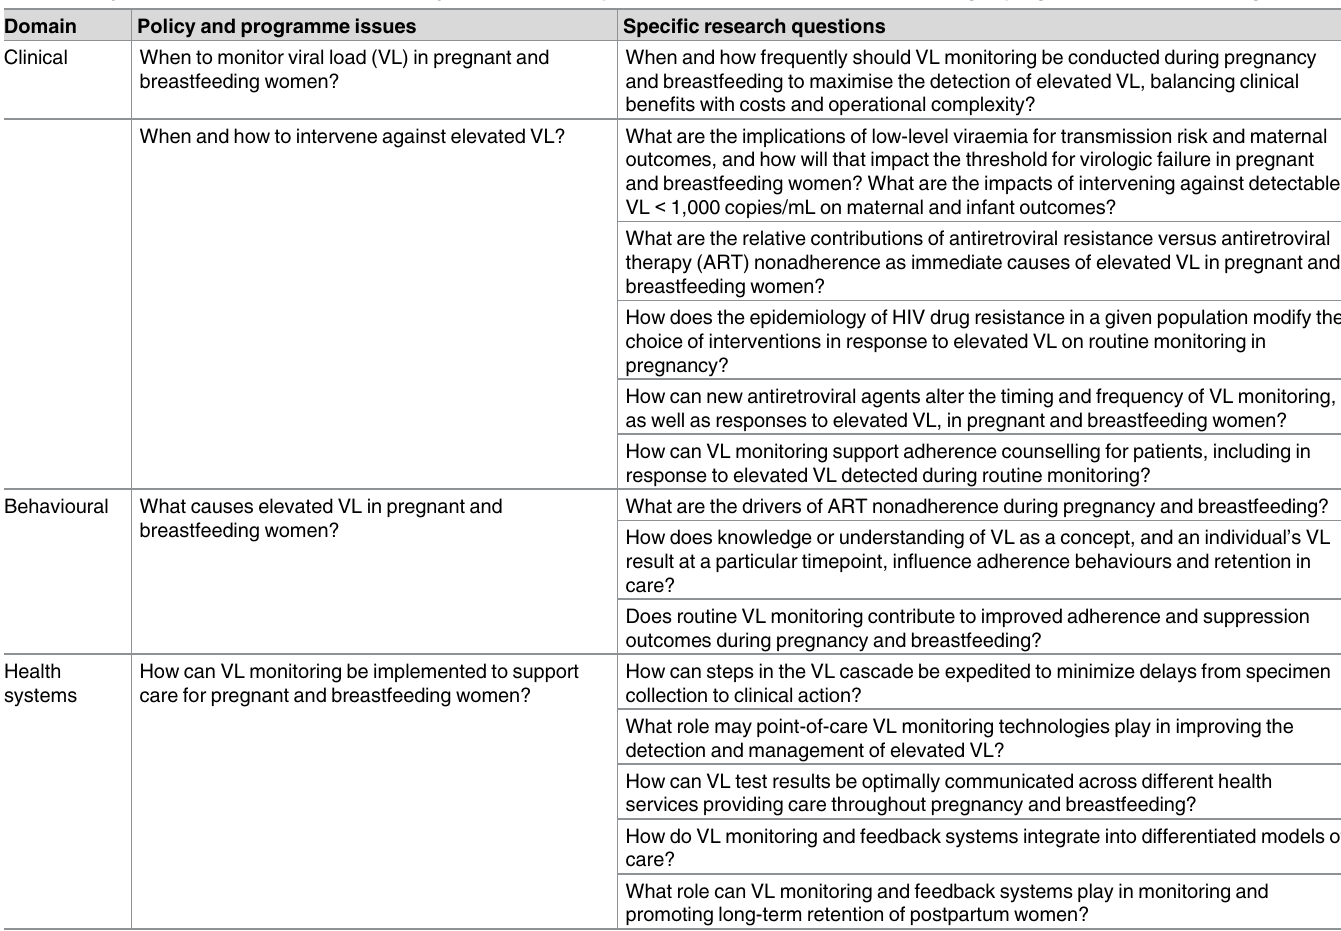
Table 1. Key clinical, behavioural, and health systemsresearchquestions related to viral load monitoring in pregnant and breastfeeding women.